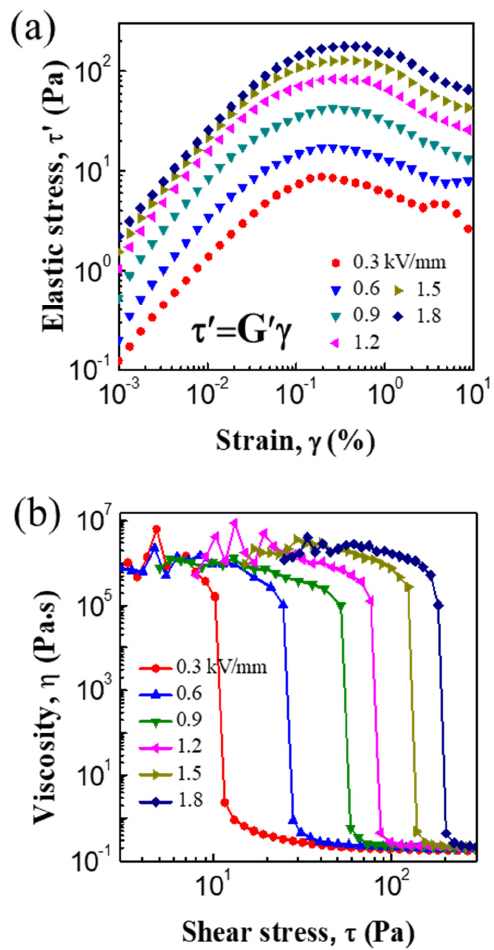
Figure 9. ( a ) Elastic stress vs. strain curves and ( b ) viscosity vs. shear stress curves of the GO / PDPA microsheet composites-based ER fluid (10 vol.%) with different electric fields. Polymers 2020 , 12 , 1984